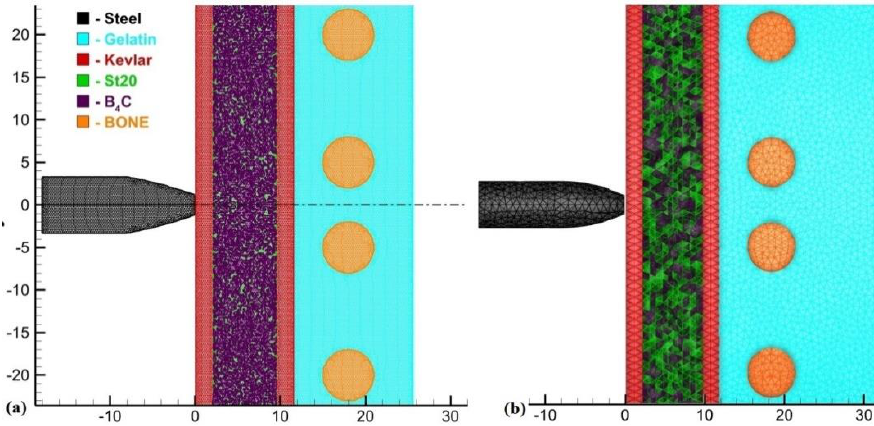
Fig. 8. Visual comparison of the two-dimensional (a) and three-dimensional models